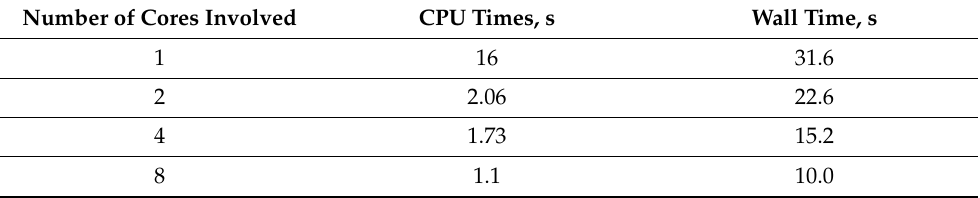
Table 9. The result of parallelizing the learning process across CPU cores for the CatBoost model. Number of Cores Involved